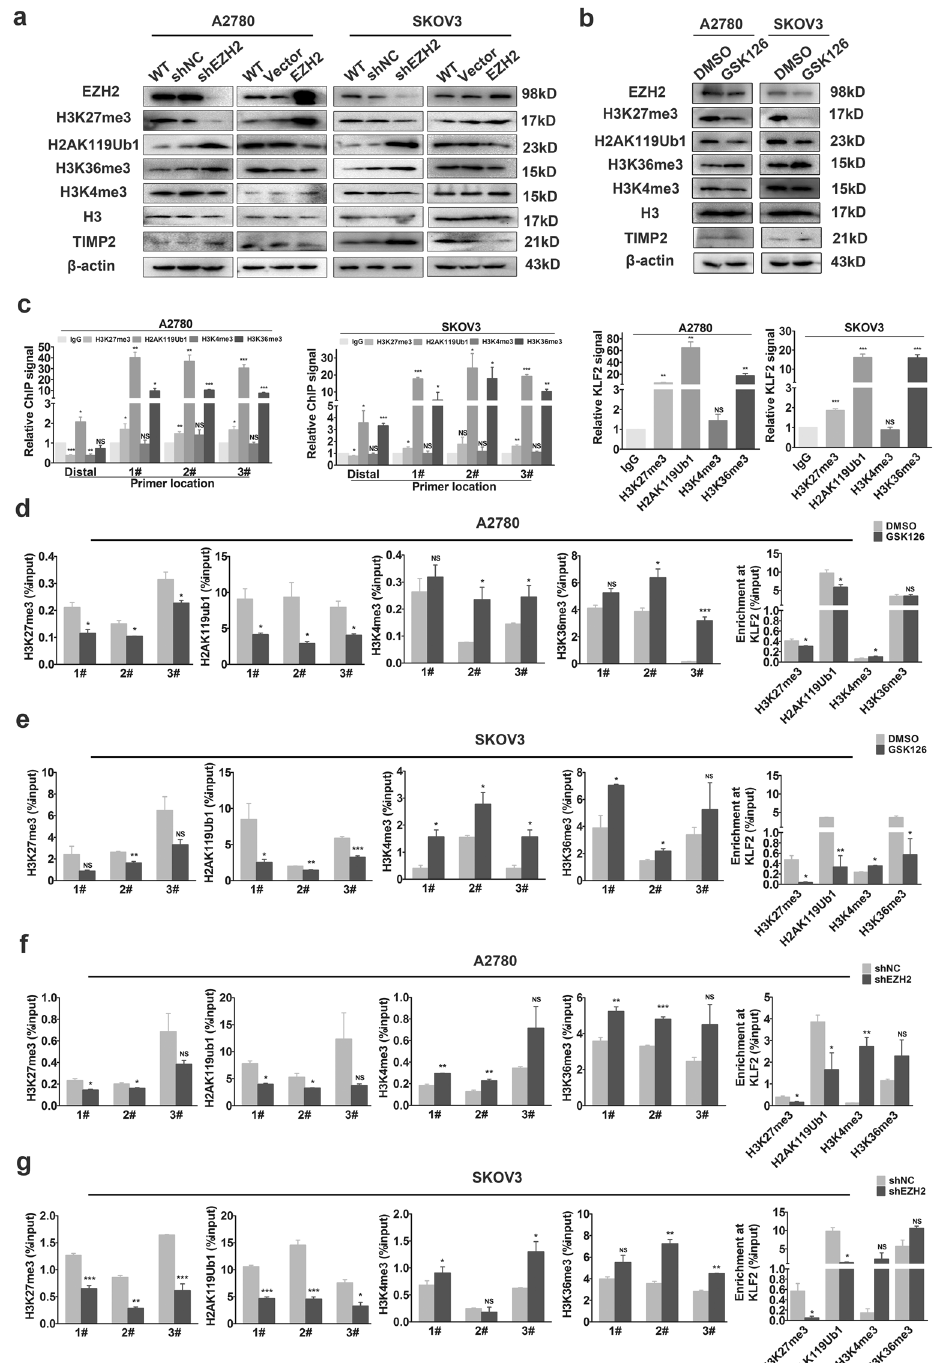
Figure 7. Inhibition of EZH2 converts histone modification mark occupancy at the TIMP2 promoter. ( a ) Western blot analysis of different histone modification marks in A2780 and SKOV3 cells after EZH2 knockdown or pharmacological inhibition by GSK126 treatment ( b ). The cropped blots are used in the figure, and full-length blots are presented in Supplementary Figs S18 and S19. ( c ) ChIP analysis of different histone modification marks at the TIMP2 promoter in A2780 and SKOV3 cells. IgG served as a negative control. ( d , e ) ChIP analysis of different histone modification marks at the TIMP2 promoter in A2780 and SKOV3 cells treated by GSK126. ( f , g ) ChIP analysis of different histone modification marks in EZH2-knockdown A2780 and SKOV3 cells. The results were normalized to the input. The EZH2 target gene KLF2 was used as a positive control. * P < 0.05; ** P < 0.01; *** P < 0.001. NS, not